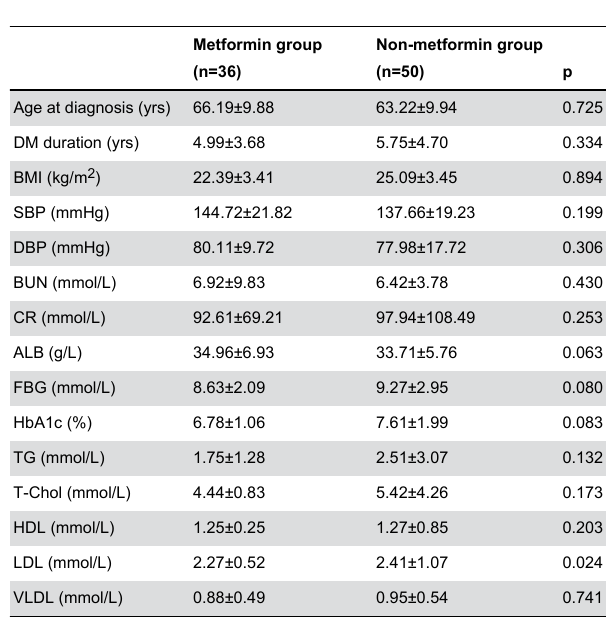
Table 1. Patient demographics and clinical characteristics at